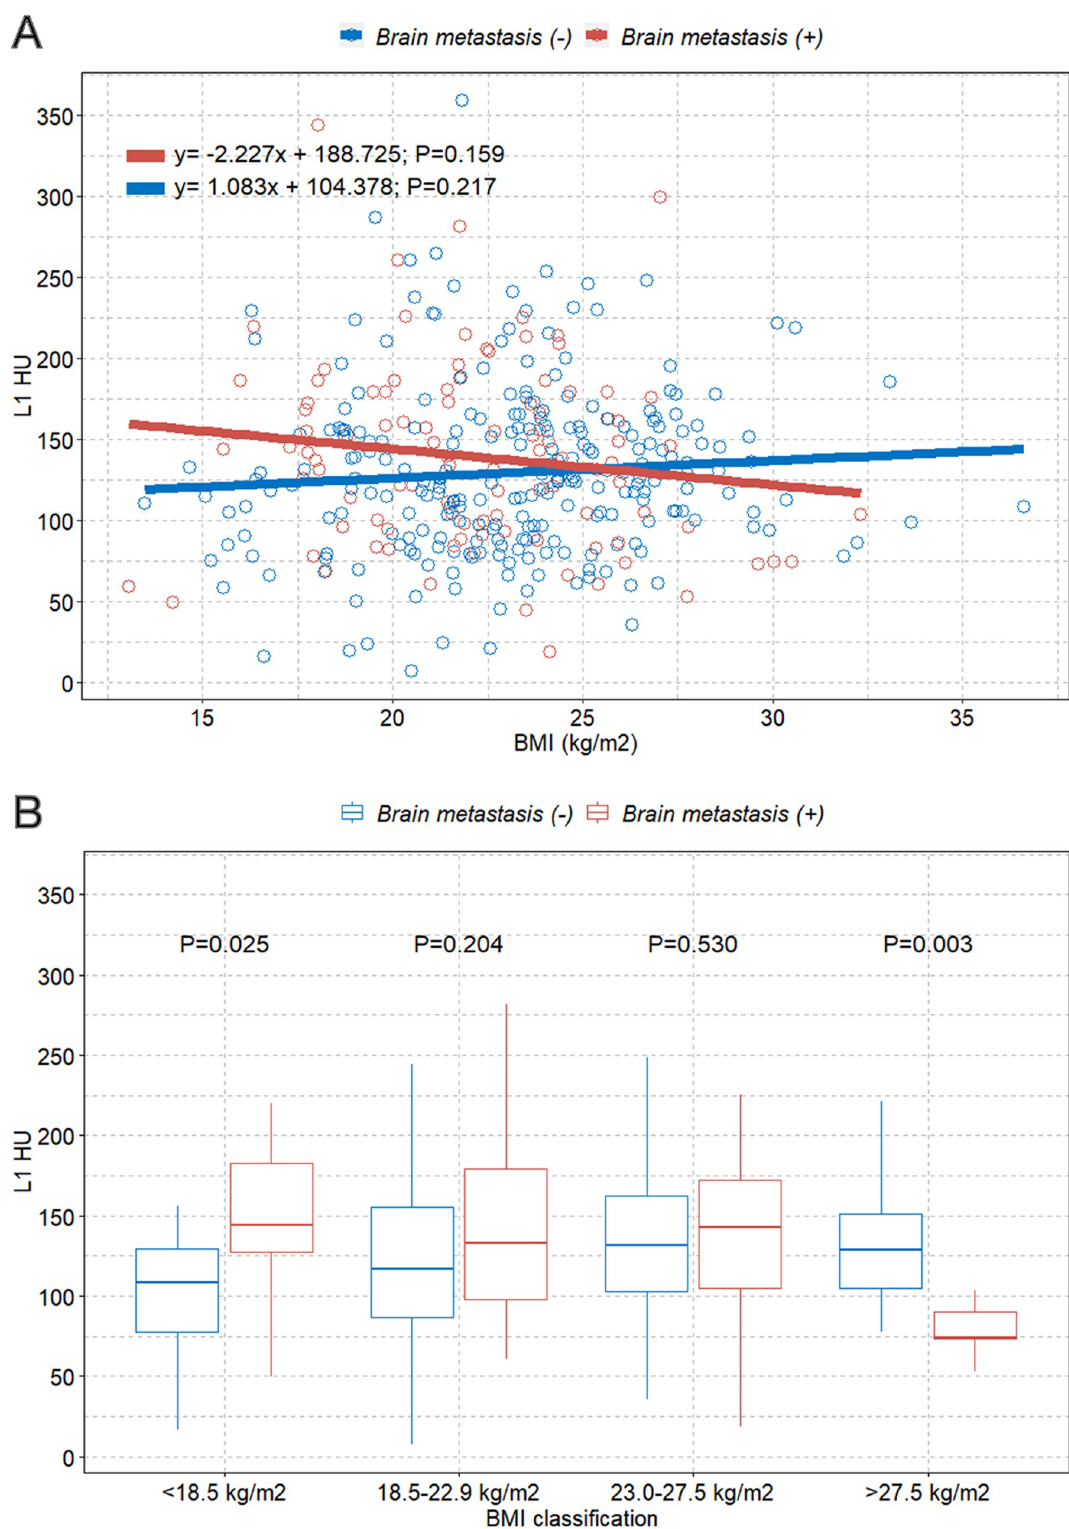
Fig 4. Scatter plot with the linear regression line and box plot. (A) Linear regression line showing the association between BMI and L1 HU values based on the presence of brain metastasis; (B) Boxplots of L1 HU values classified according to four BMI categories (underweight, normal, overweight, and obese). BMI = body mass index; HU = Hounsfield unit. https://doi.org/10.1371/journal.pone.0218825.g004 PLOS ONE | https://doi.org/10.1371/journal.pone.0218825 June 21,